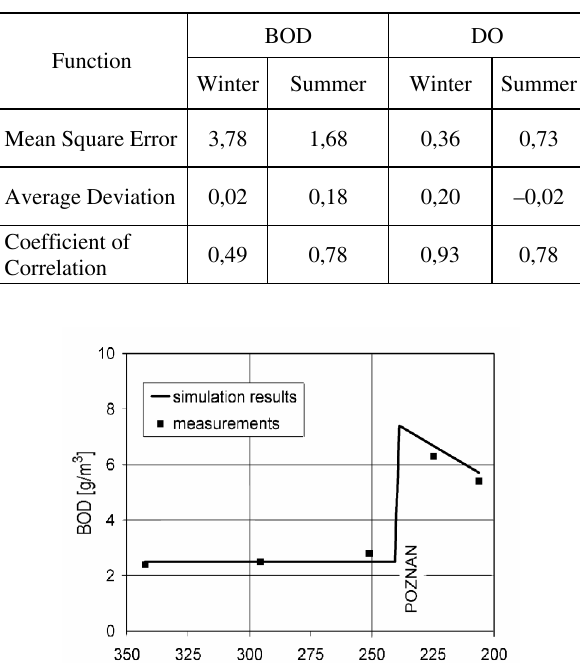
Table 3. Values of quantifying characteristics obtained in the